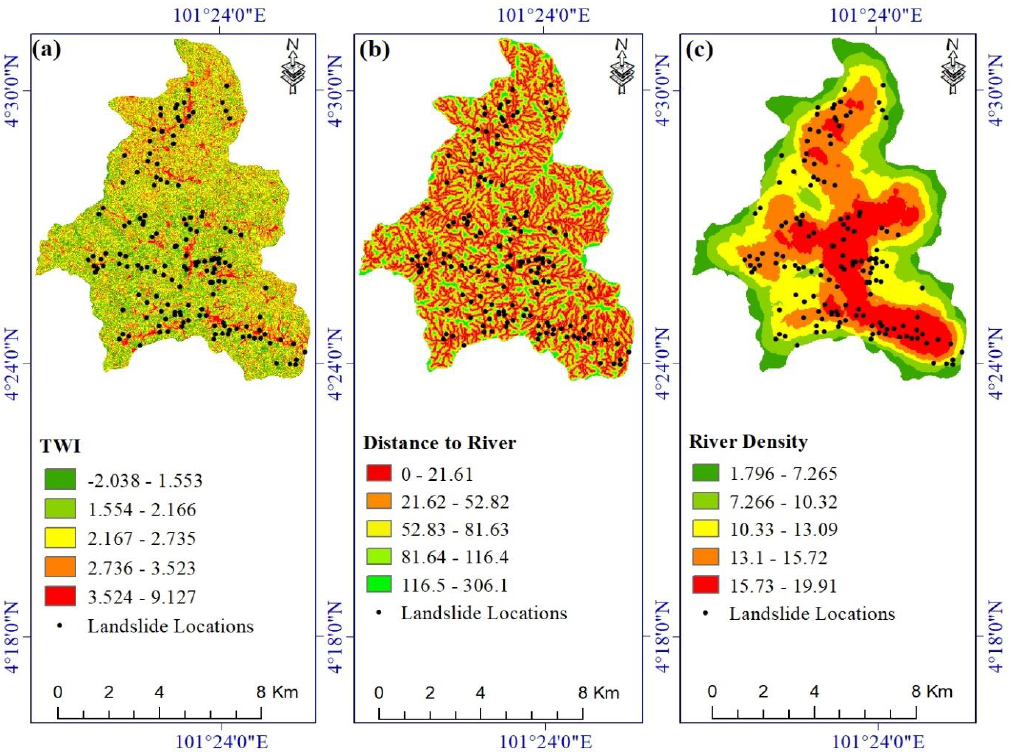
Figure 4. Landslide conditioning factors: ( a ) TWI, ( b ) distance to river, and ( c ) river density.